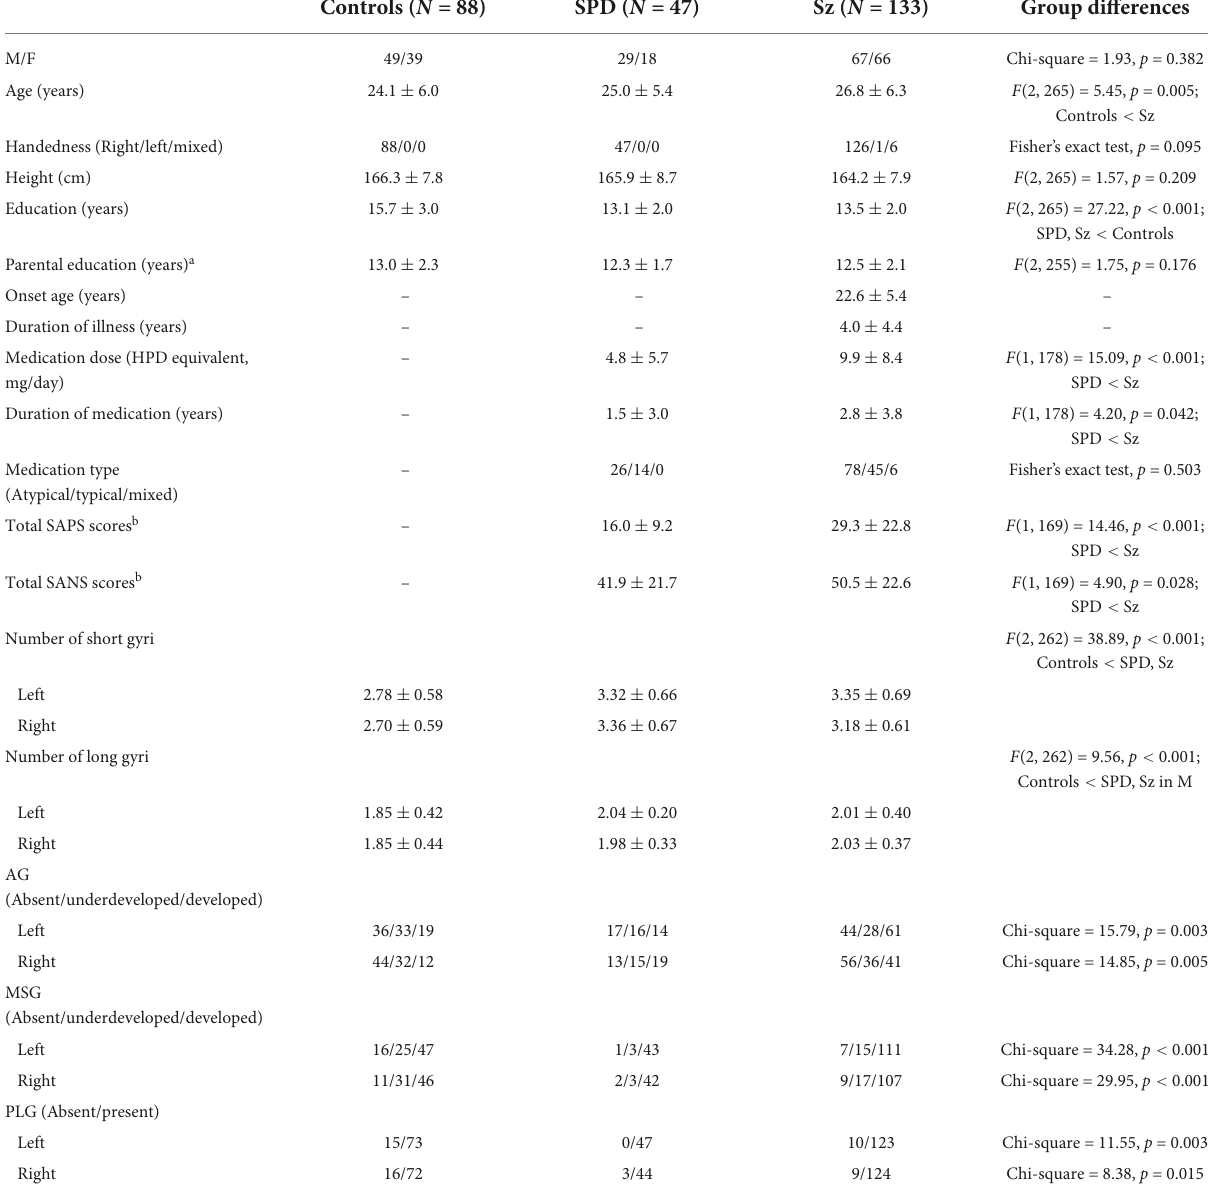
TABLE 1 Sample characteristics and gross insular morphology of